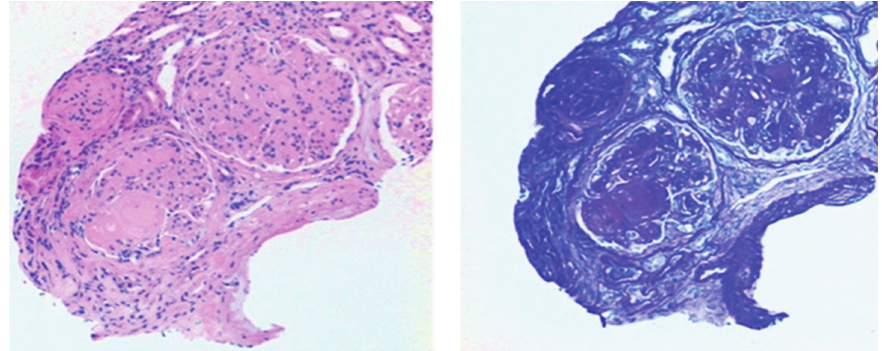
Figure 9: Diabetic Nephropathy: extensive mesangial expansion is seen, with rounded acellular mesangial nodules (Kimmelstiel-Wilson nodules) (hematoxylin-eosin and PAS, original magnification ×